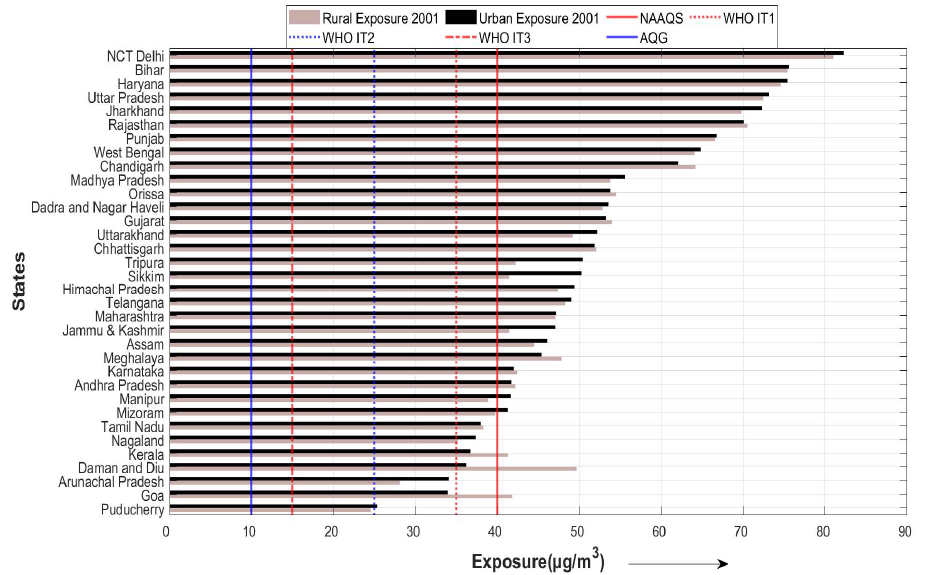
Figure 10. State-wise urban and rural population-weighted PM 2.5 exposure in 2001. World Health Organization air quality guideline, WHO AQG (10 µ g / m 3 ) and the interim targets (IT-1: 35 µ g / m 3 ; IT-2: 25 µ g / m 3 and IT-3: 15 µ g / m 3 ), and national ambient air quality standard, NAAQS (40 µ g / m 3 ) are marked by the vertical lines. The states / union territories are arranged in the decreasing order of PM 2.5 level.